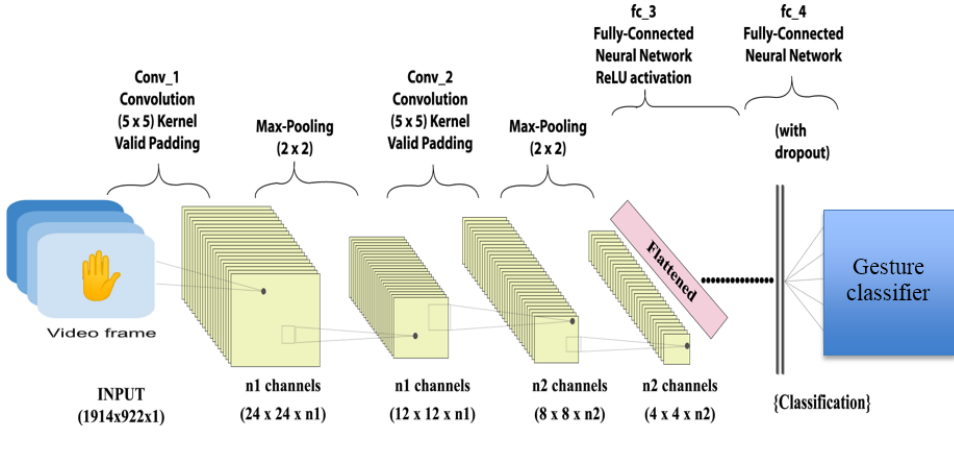
Figure 7. Gesture recognition using